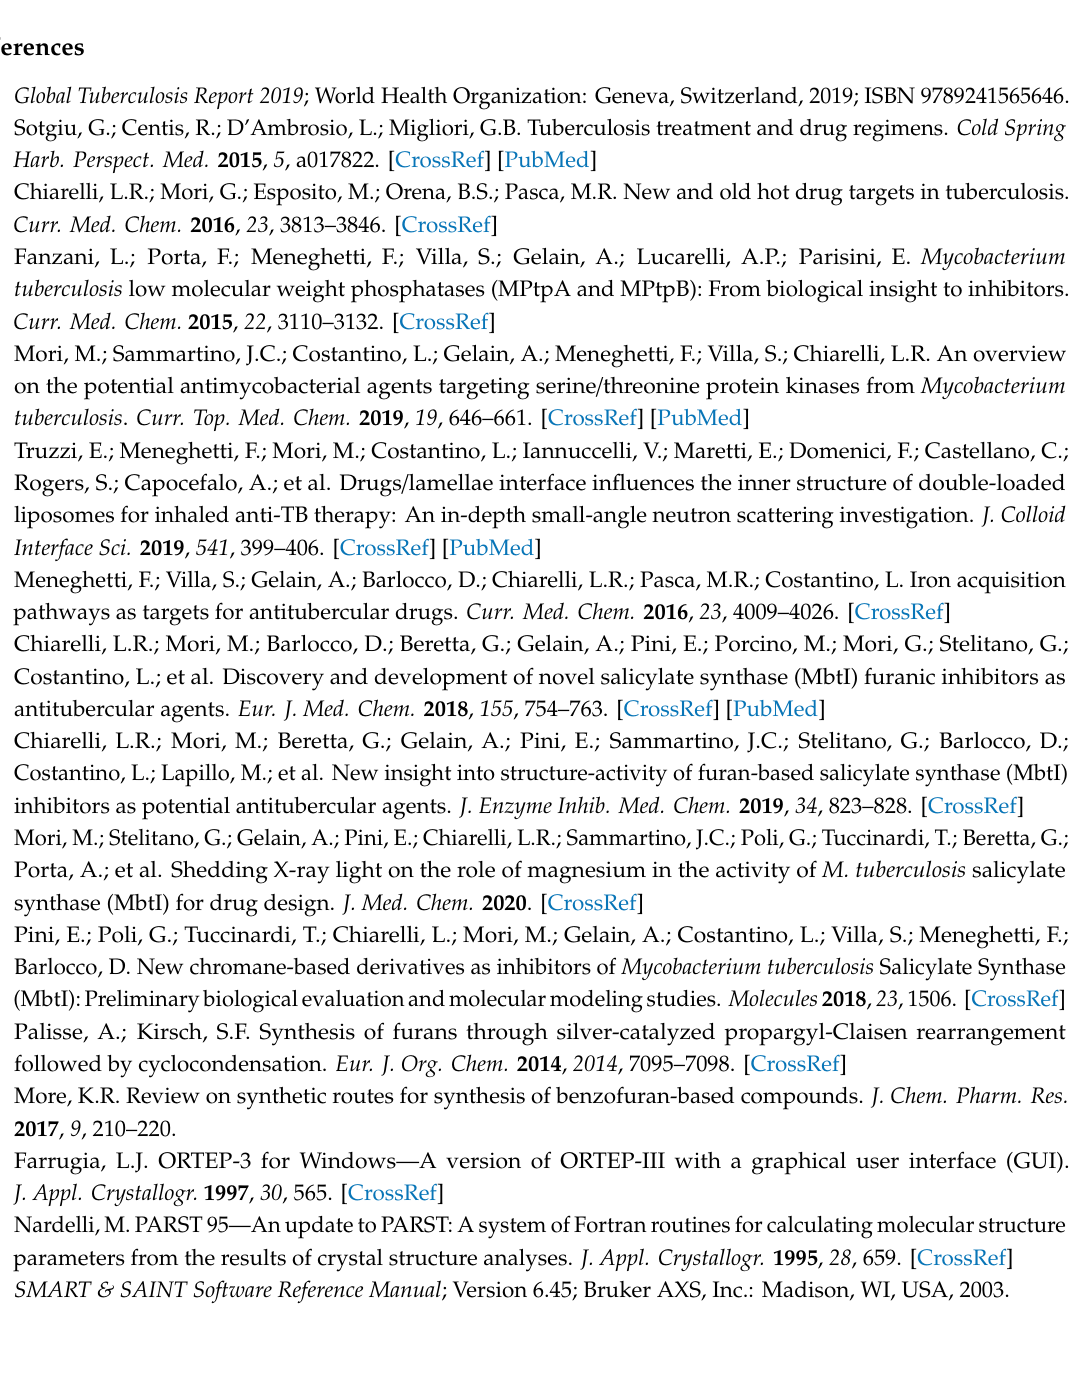
Figure S1: 1 H-NMR spectrum of 6-hydroxy-2-methylbenzofuran-4-carboxylic acid methyl ester ( 2 ), Figure S2: 13 C-NMR spectrum of methyl ester ( 2 ), Figure S3: COSY spectrum of methyl ester ( 2 ), Figure S4: NOESY spectrum of methyl ester ( 2 ), Figure S5: HSQC spectrum of methyl ester ( 2 ), Figure S6: HMBC spectrum of methyl ester ( 2 ), Figure S7: FT-IR spectrum of methyl ester ( 2 ), Figure S8: ESI-MS spectrum of methyl ester ( 2 ), Figure S9: 1 H-NMR spectrum of 6-hydroxy-2-methylbenzofuran-4-carboxylic acid ( 1 ), Figure S10: 13 C-NMR spectrum of acid ( 1 ), Figure S11: FT-IR spectrum of acid ( 1 ), Figure S12: ESI-MS spectrum of acid ( 1